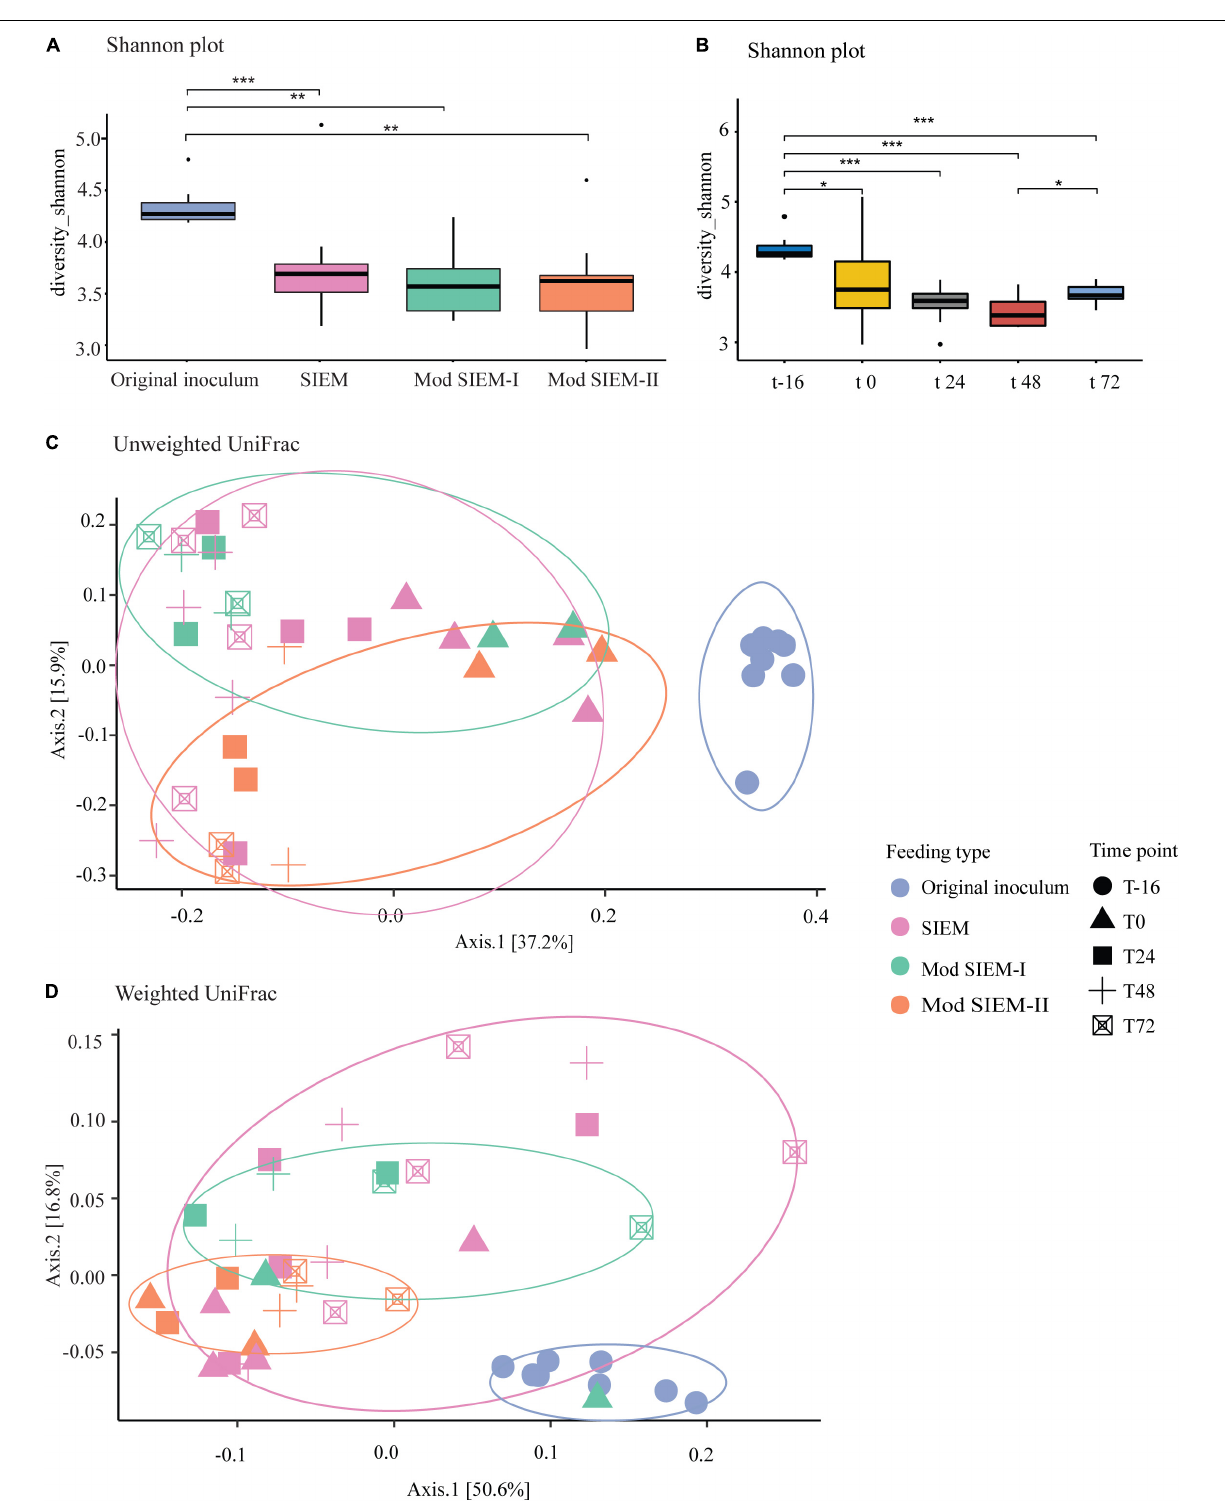
FIGURE 2 | Bacterial diversity. (A) . For the alpha diversity, Shannon indexes were calculated to verify the abundance and evenness of the species present in the of Chicken ALIMEntary tRact mOdel-2 (CALIMERO-2) samples. Data are presented as mean ( n = 2) ± sd. Significant difference is shown between original inoculum and SIEM ( p < 0.001) and original inoculum and modified SIEM-I and II ( p < 0.05). (B) . Shannon index for the CALIMERO-2 samples taken at different timepoints. The beta diversity is represented as principal coordinates analysis (PCoA) using the unweighted UniFrac (C) or the weighted UniFrac (D) for the cecal microbiota of chickens form the CALIMERO-2